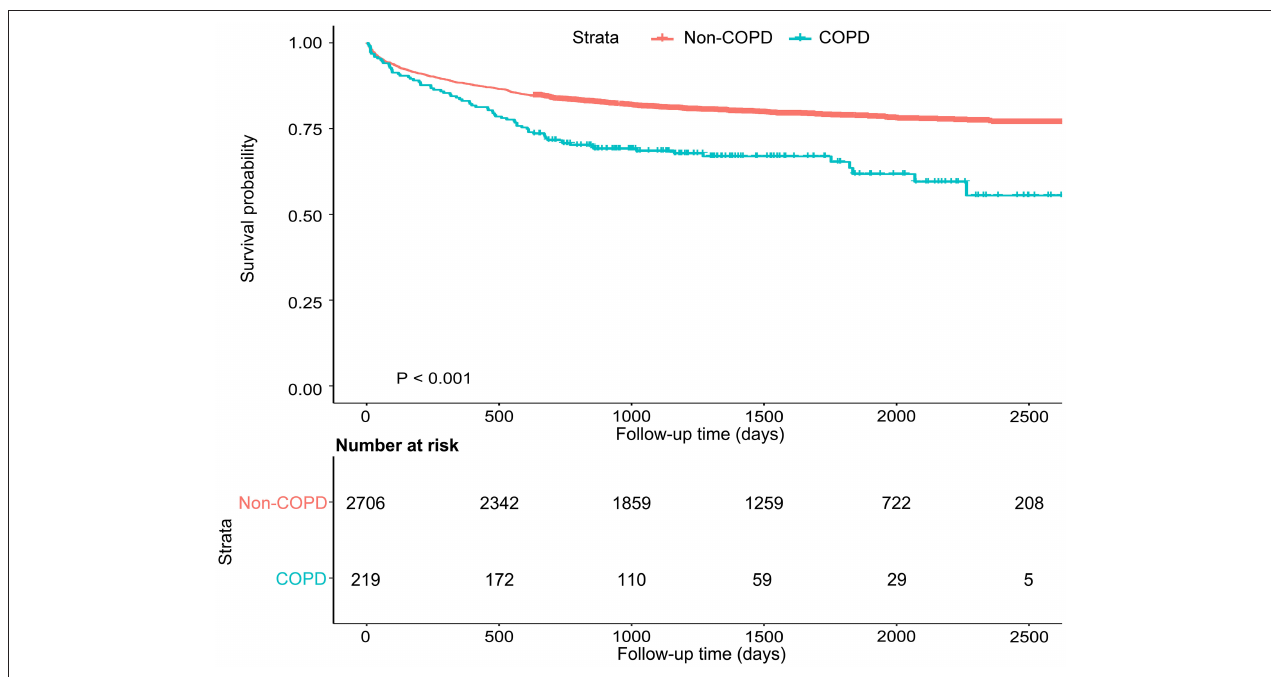
FIGURE 2 | Kaplan–Meier curve of mortality after aSAH among patients with and without COPD.